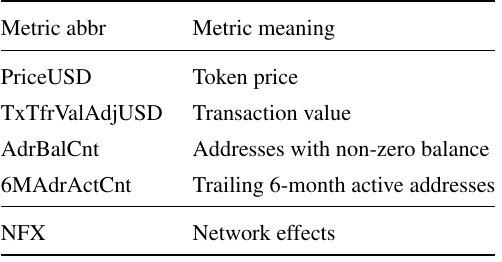
Table 2. Legend of metrics in